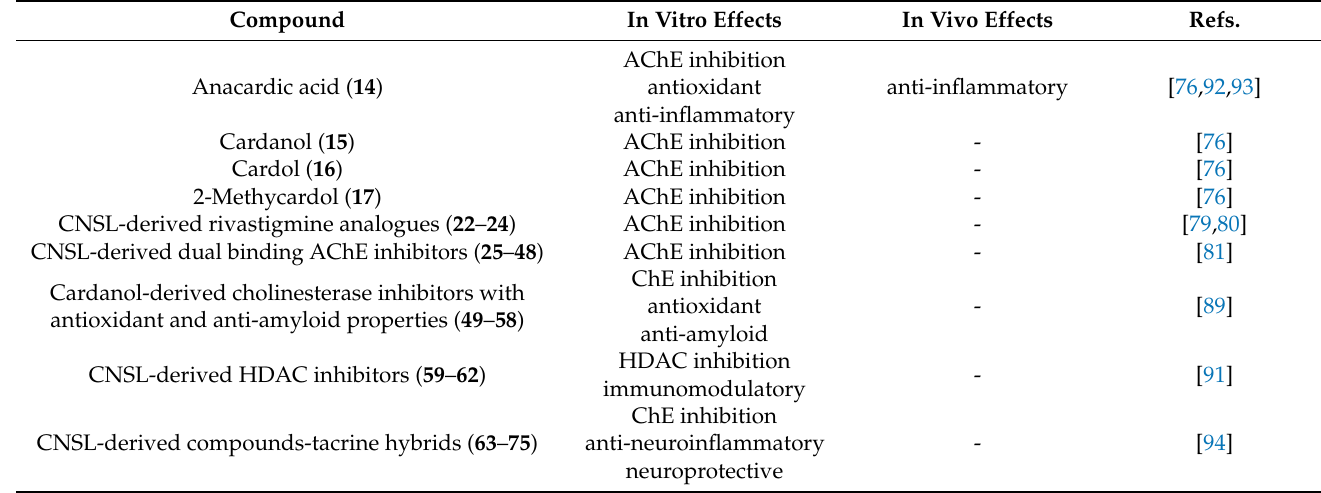
Table 6. In vitro and in vivo anti-AD effects of CNSL phenolic lipids and their synthetic derivatives.